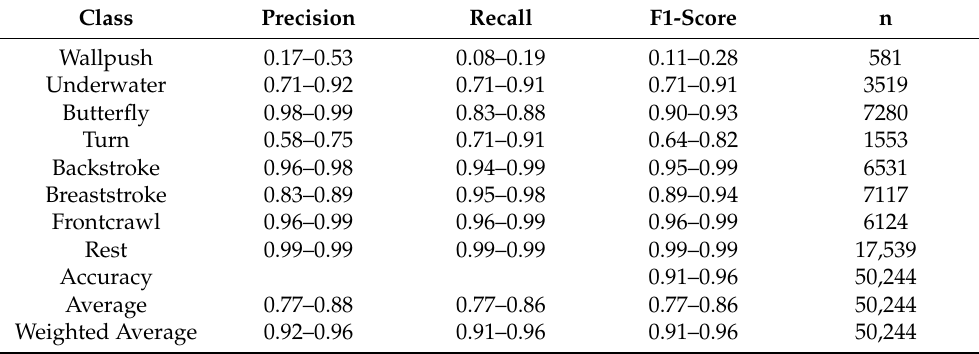
Table 5. Performance results in swimming activity recognition on testing set before and after filtering step ( ˆY – ˆY f ).